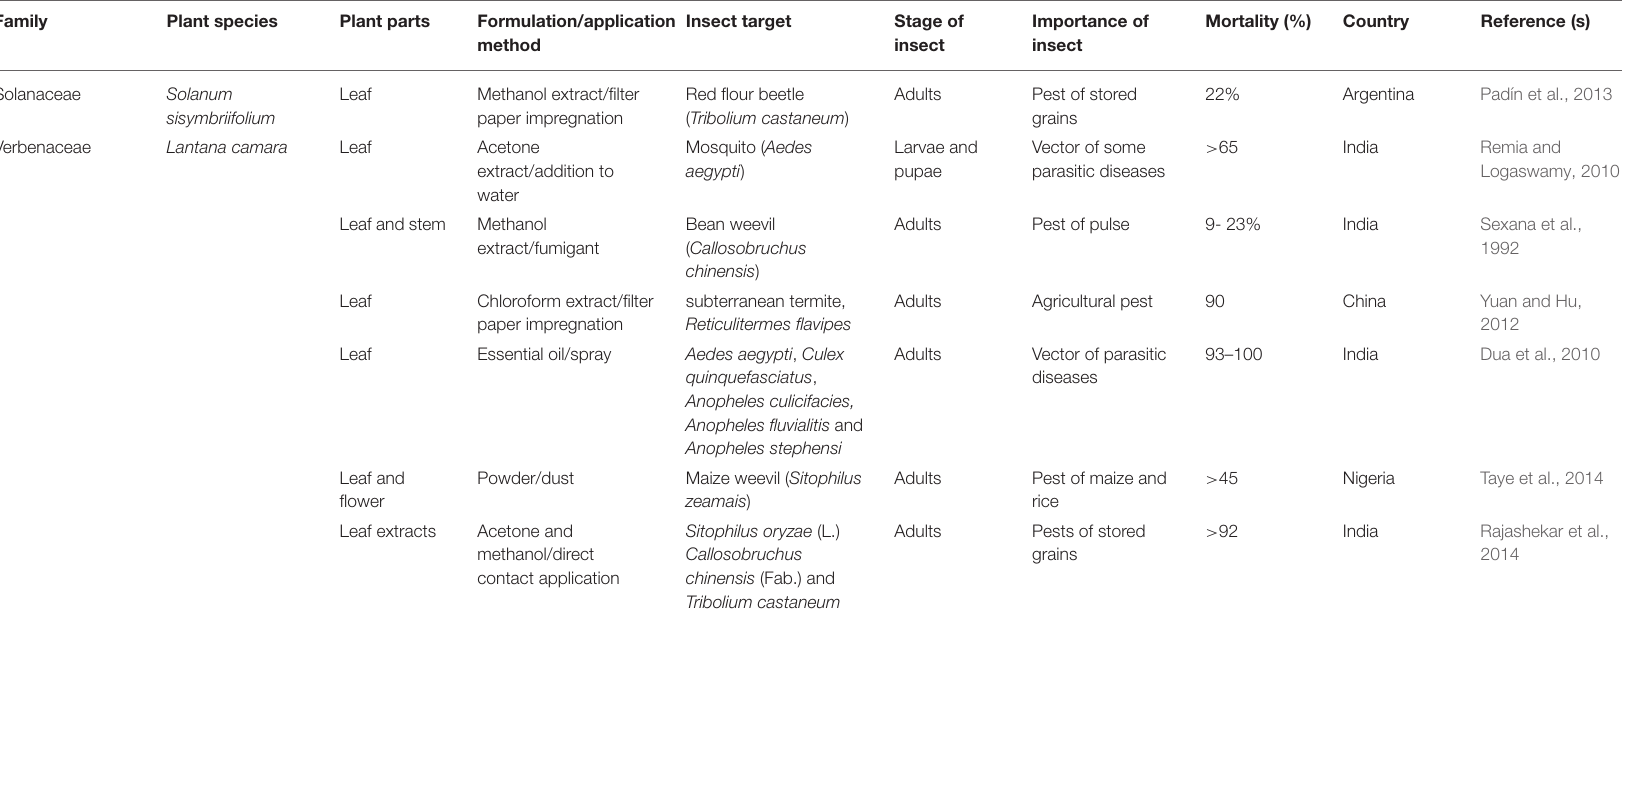
TABLE 2H | Published reports on the insecticidal activities of some plant species with invasive potentials in sub-Saharan